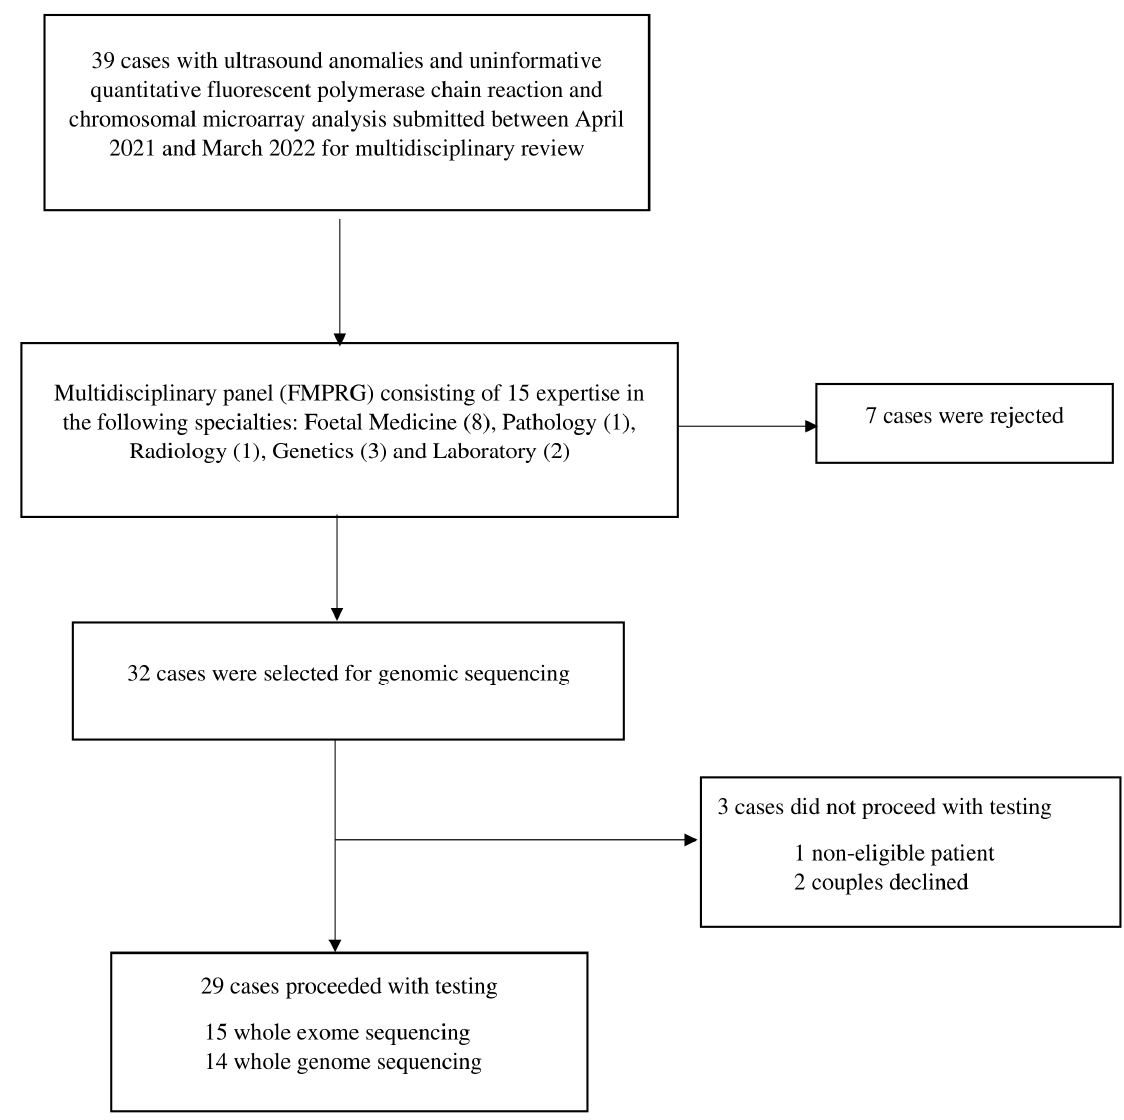
Figure 1. Flowchart of the genome-wide sequencing service. Table 1. Basic patient characteristics, fetal phenotypic features, genetic results and pregnancy out- comes.